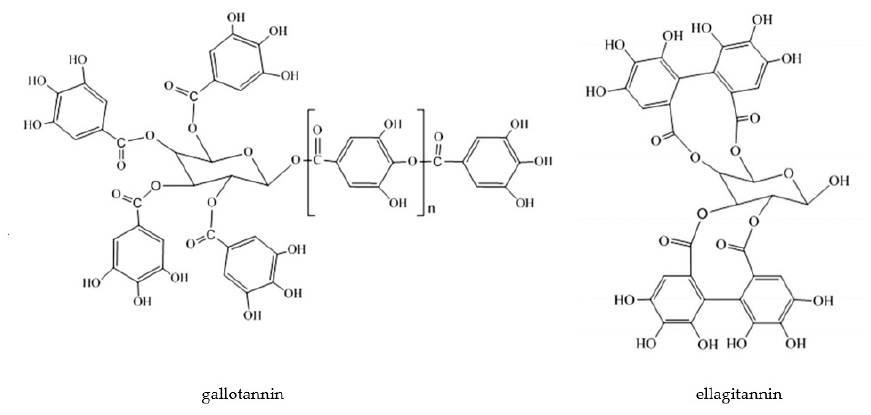
Figure 4. Structure of hydrolysable tannins, gallotanin, and ellagitannin.